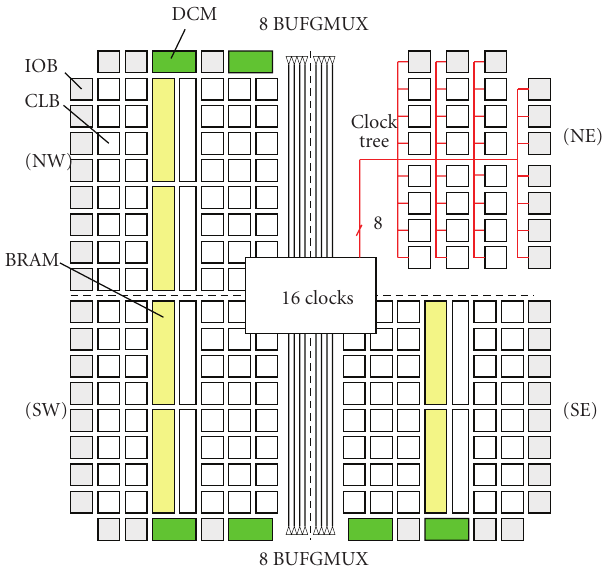
Figure 2: Simplified view of the Xilinx Virtex II clock distribution network.